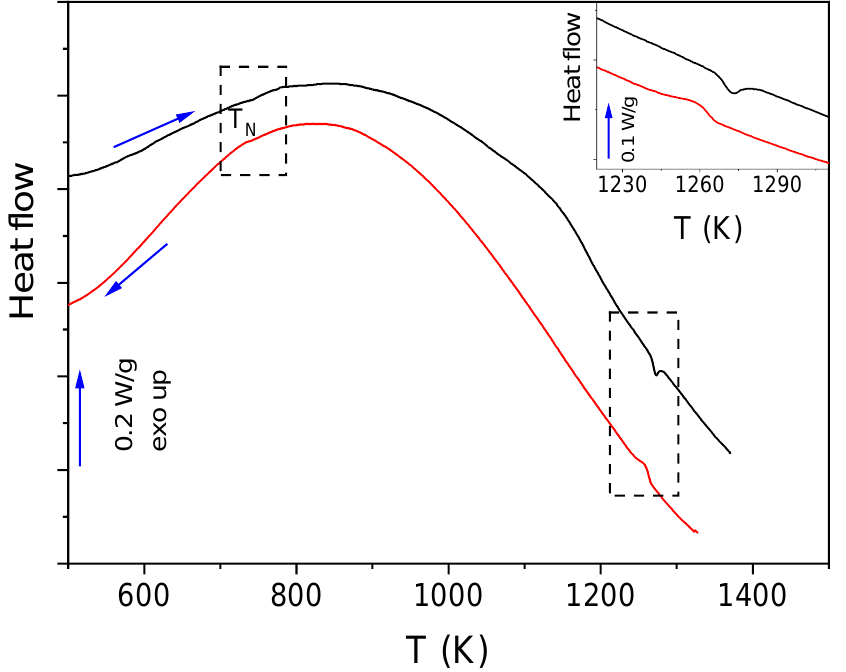
Figure 4. DTA scans at 10 K min − 1 for phase-pure LaFeO 3 obtained by RFS. Inset shows a horizon- tally zoomed plot in a limited range of temperatures (black and red lines correspond to heating and cooling, respectively).